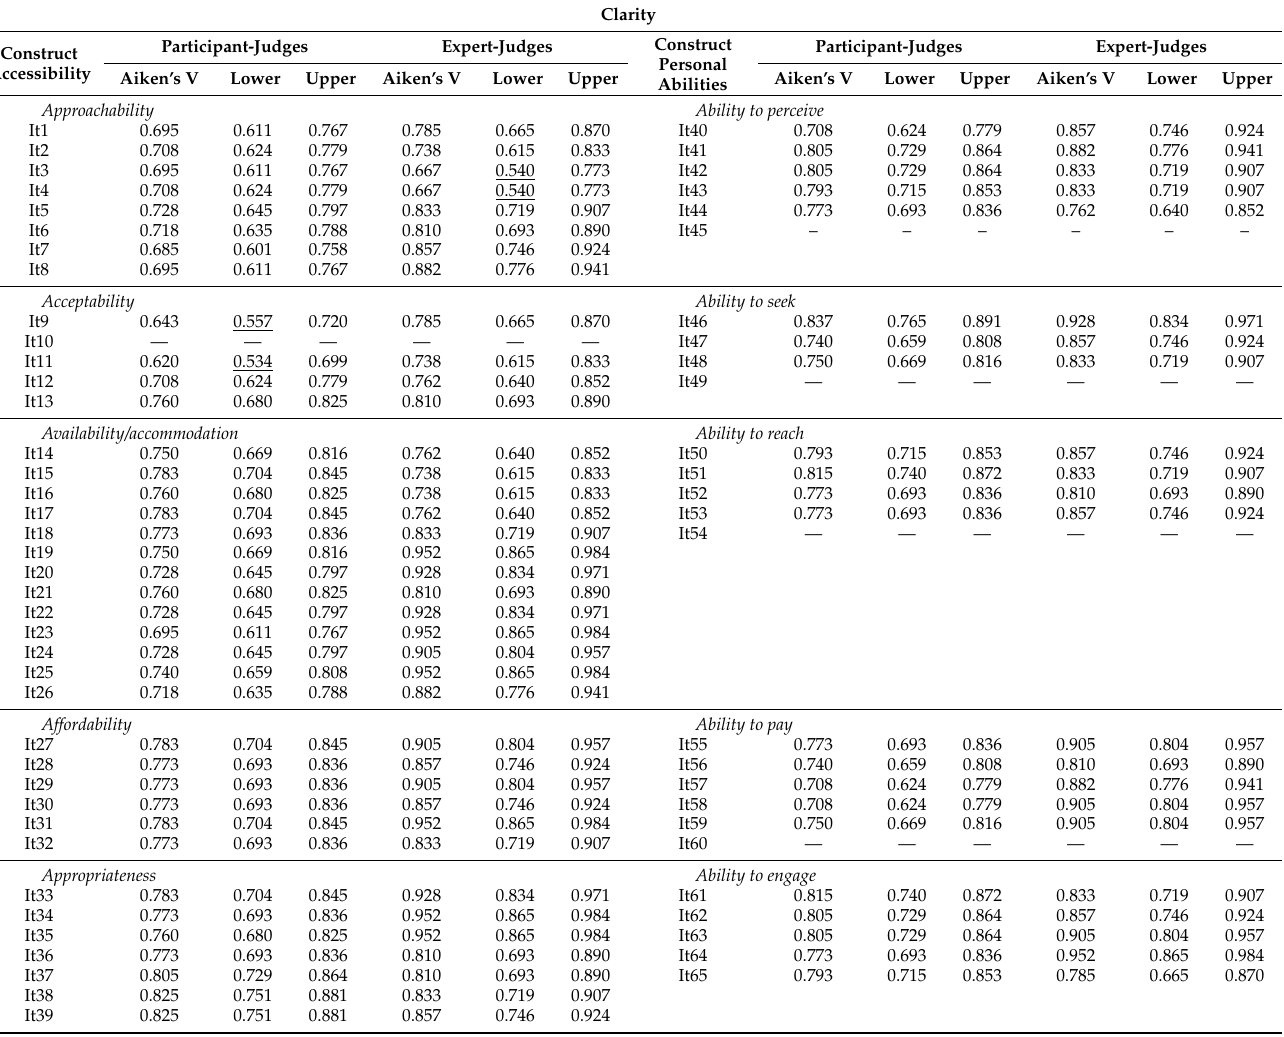
Figure 3. Aiken’s V and confidence intervals for relevance as evaluated by expert-judges ( n = 7) according to the Personal abilities construct. Table 3. Aiken’s V and confidence intervals for clarity as evaluated by participant-judges ( n = 23) and expert-judges ( n = 7).